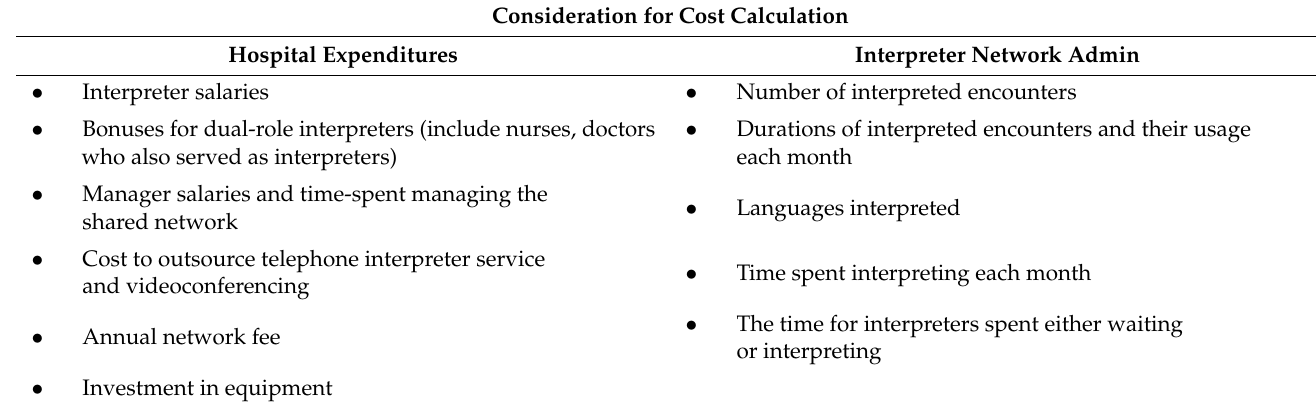
Table 5. Data sources for cost